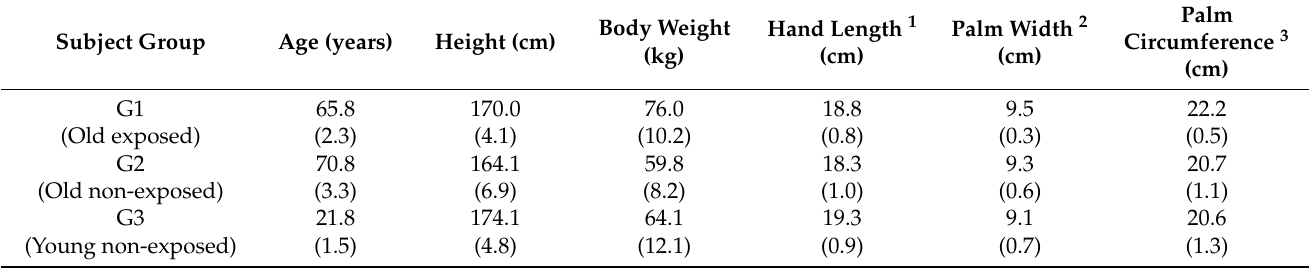
Table 1. Anthropometric data of the subjects participating in the